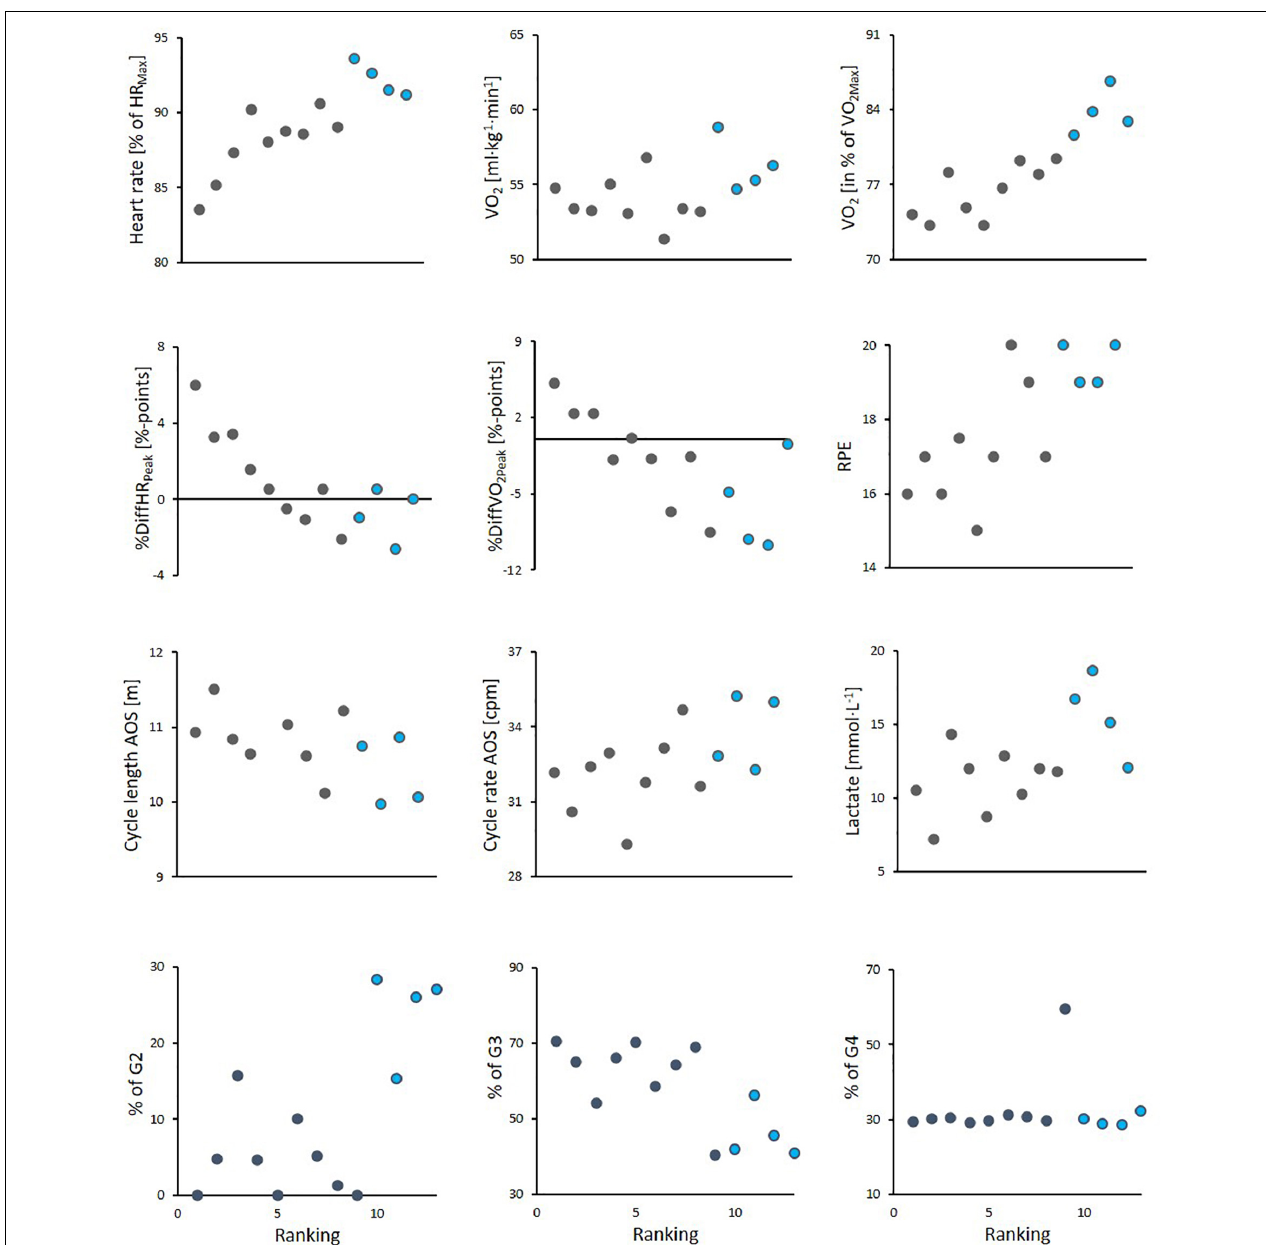
FIGURE 5 | Scatter plots for athlete ranking in the simulated mass-start with the following parameters: mean values of heart rate (HR), oxygen uptake (VO 2 ) and sub-technique selection during the first three laps of the simulated mass-start, as well as to the rate of perceived exhaustion (RPE) for the initial 21-min of the mass-start, cycle length and cycle rate during the first 3 steps of the incremental all-out sprint (AOS), blood lactate concentration (BLa) measured directly after the simulated mass-start and the difference between peak values of relative heart rate (%HR Max ) and oxygen uptake (%VO 2 Max ) in the main part of the mass-start and the corresponding values during the AOS (%DiffHR Peak /%DiffVO 2 Peak ). The 9 skiers completing the entire protocol without breaks are shown with black color, while the 4 skiers who needed breaks are shown in blue